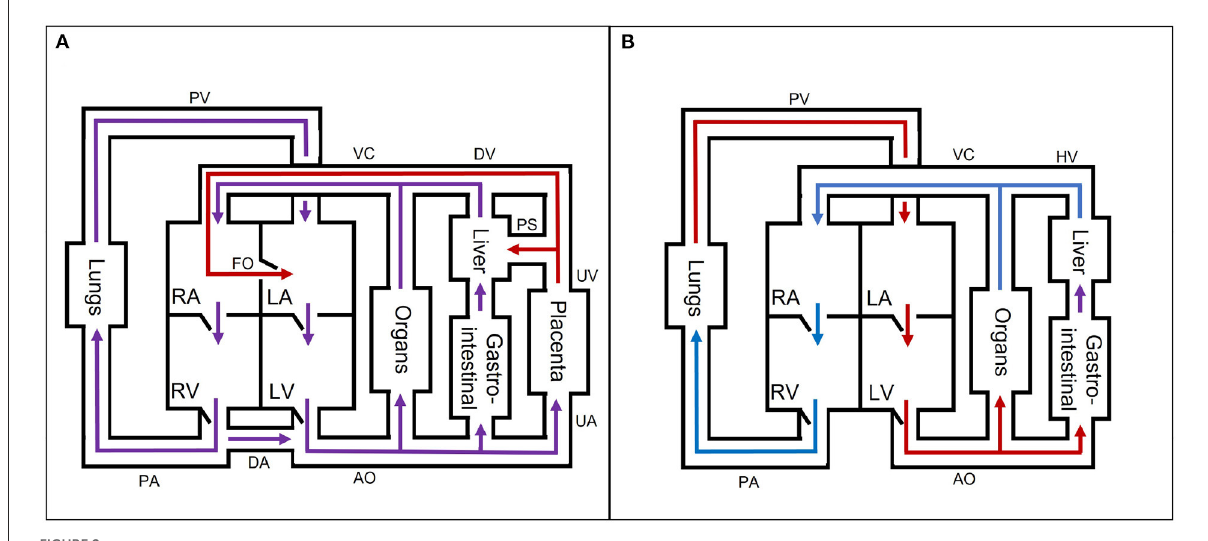
FIGURE2 A simple schematic overview of the (A) fetal and (B) neonatal circulation with oxygen- and nutrient-rich (red), oxygen- and nutrient-poor (blue), and oxygen- and nutrient-rich and -poor mixed (purple) blood flow direction. AO, aorta; DA, ductus arteriosus; DV, ductus venosus; FO, foramen ovale; HV, hepatic veins; LA, left atrium; LV, left ventricle; PA, pulmonary arteries; PS, portal sinus; PV, pulmonary veins; RA, right atrium; RV, right ventricle; UA, umbilical arteries; UV, umbilical vein; VC, inferior and superior vena cava. The block “organs” represents all other organs, which are not separately mentioned in the